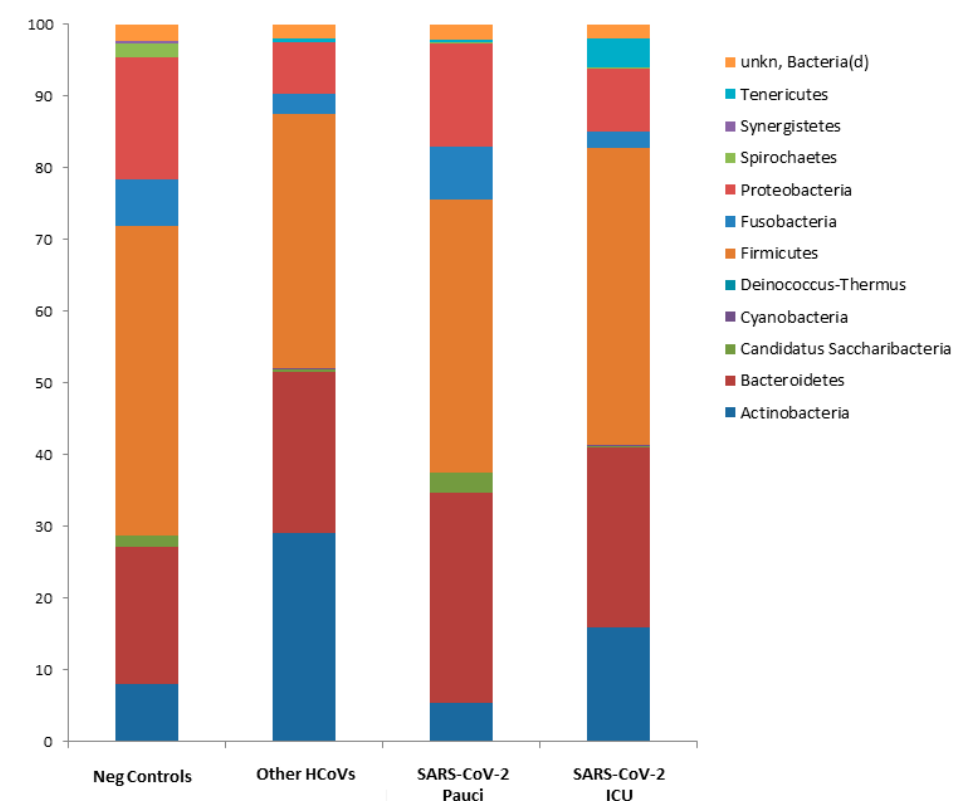
Figure 2. Microbiota composition of Neg Controls, Other HCoVs, SARS-CoV-2 Pauci and SARS-CoV-2 ICU at the phylum level. The mean value of all the detected taxa is represented.